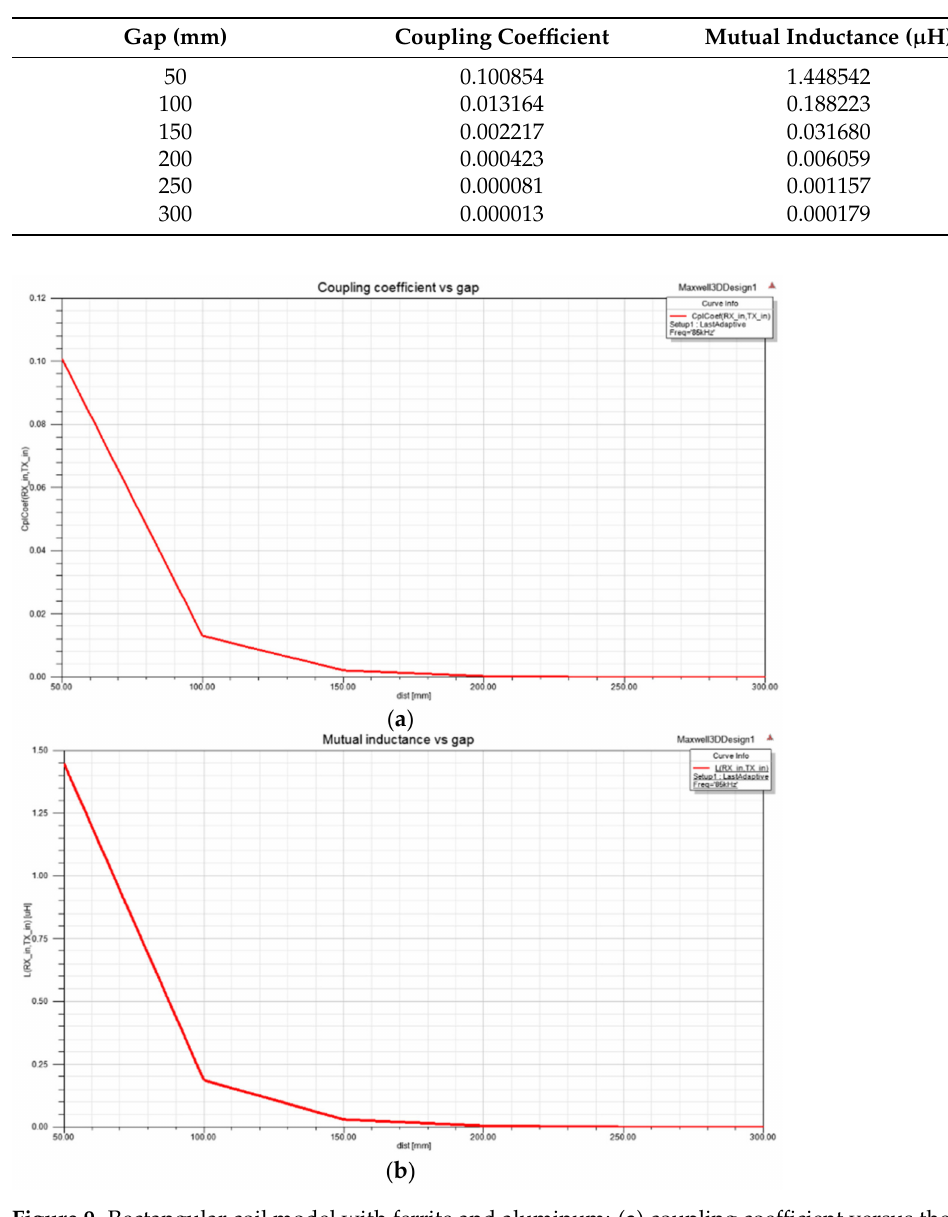
Figure 9. Rectangular coil model with ferrite and aluminum: ( a ) coupling coefficient versus the gap variation, ( b ) mutual inductance versus the gap